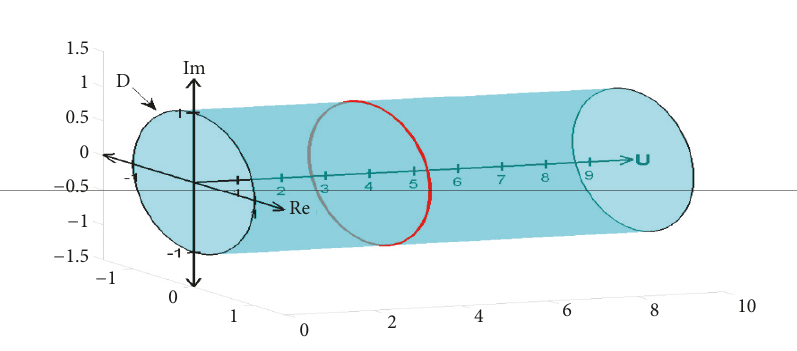
Figure 1: Complex fuzzy set defined in